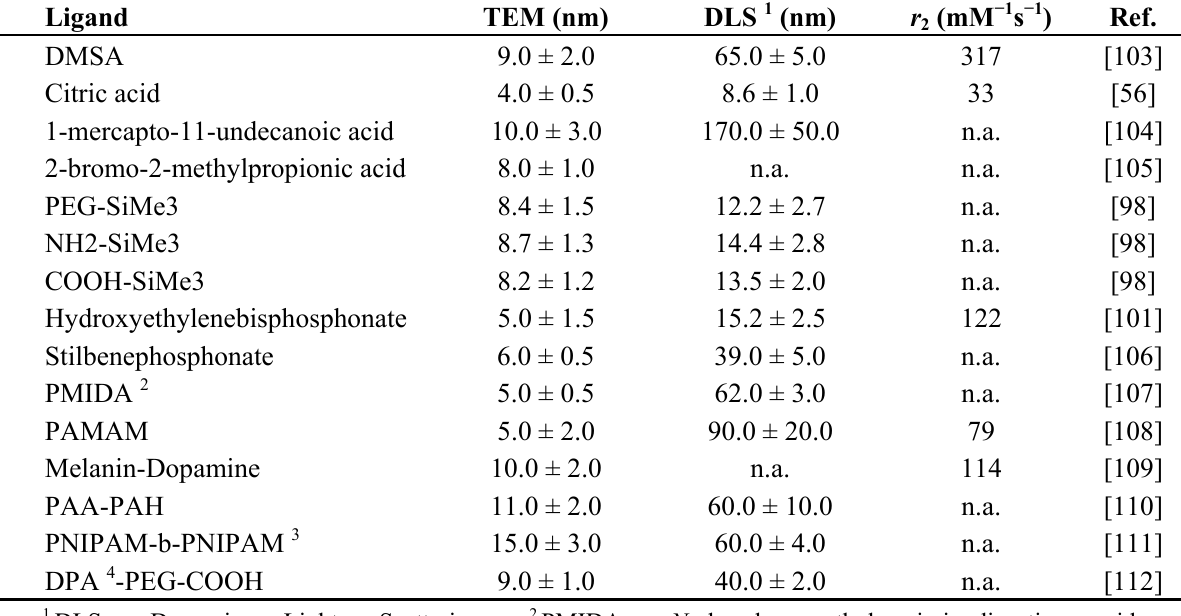
Table 2. Summary of the main properties for the most common ligand-exchange